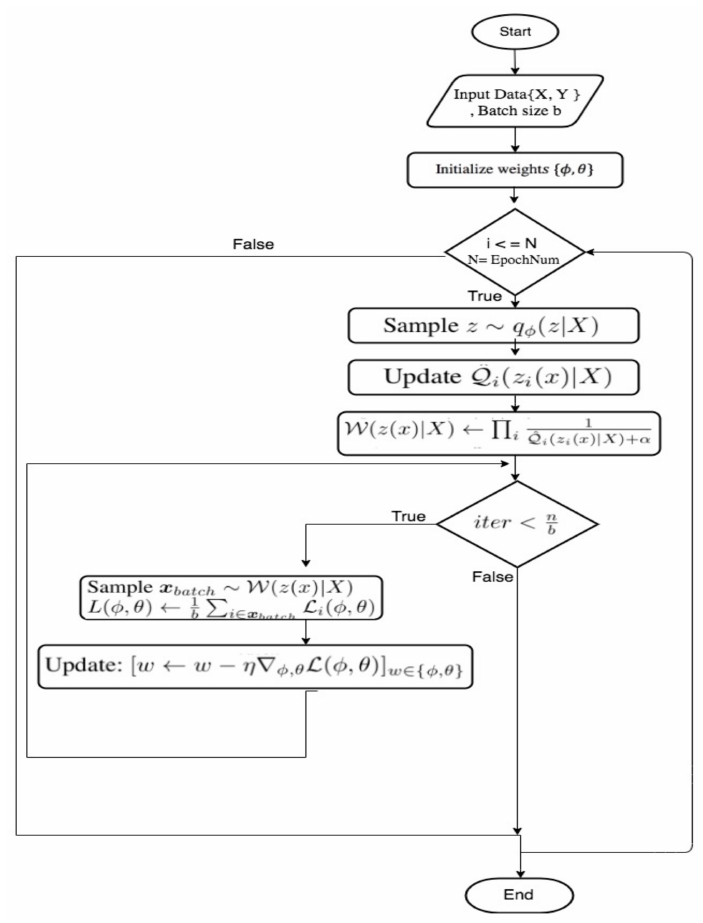
Figure 6. The resampling algorithm for the DE-VAE model